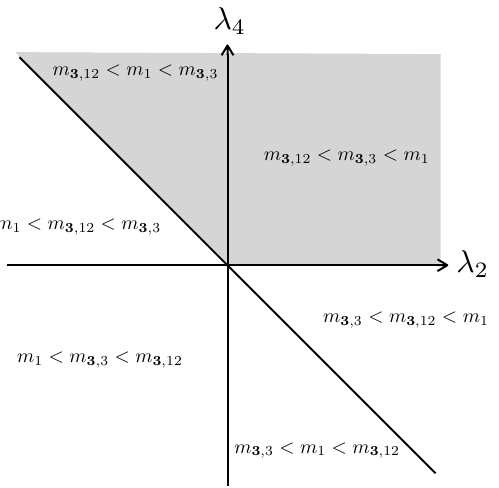
Figure 6 . The six possible mass orderings in terms of (cid:21) 2 and (cid:21) 4 . The gray region is phenomeno- logically disfavored since the lightest scalar (cid:12)eld is not a neutral singlet scalar. where m 3 ; 3 is the mass of the real part of h 3 , and m 3 ; 12 is the mass of the real parts